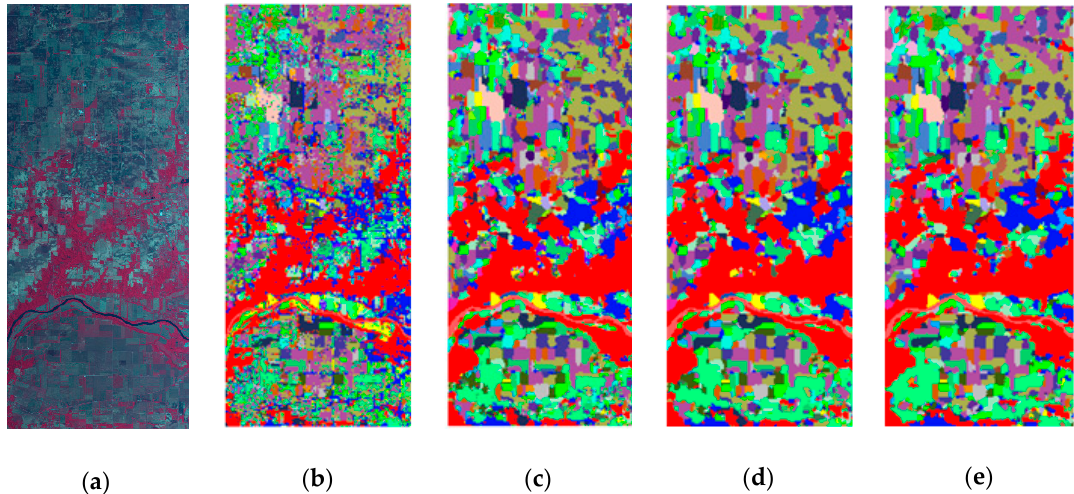
Figure 8. ( a ) False-color composite image of Indian Pines dataset; The classification maps using ( b ) EMP-RF; ( c ) PCA-DenseNet; ( d ) DenseNet-CRF; ( e ) Semi-GAN.